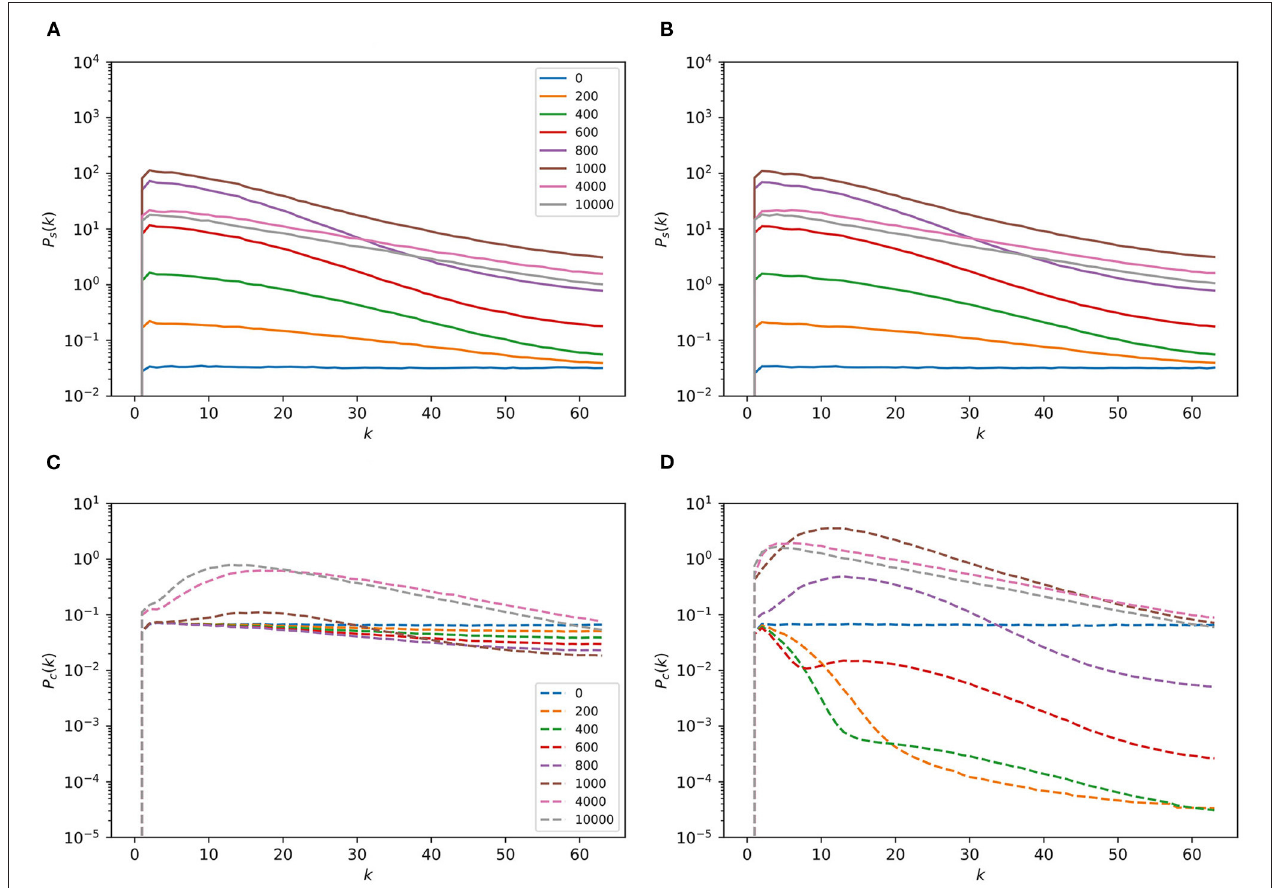
FIGURE 5 | Time evolution of the angular average of the power spectra of the nematization P s ( k ) and the concentration P c ( k ), as functions of the wave number k , from the tensor Equations (14) for conditions of low and high NP mobility R : (A) P s ( k , t ) for R Each curve corresponds to the time indicated in the inset legends. Now, the nematization power spectrum increases quickly but non-monotonically with time. Nevertheless, the concentration power spectrum P c ( k ) for low NP mobility still goes through a quiescent stage before undergoing sudden increase, and (initially) decreases at high wave numbers for high NP mobility. Parameters g